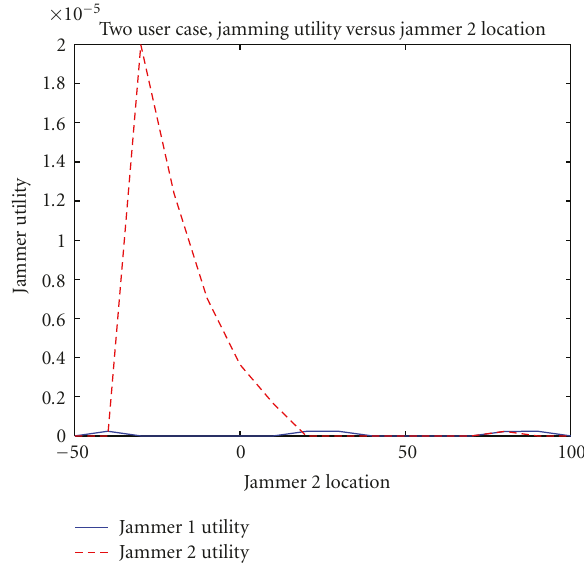
Figure 9: Utility versus the location of the second jammer.